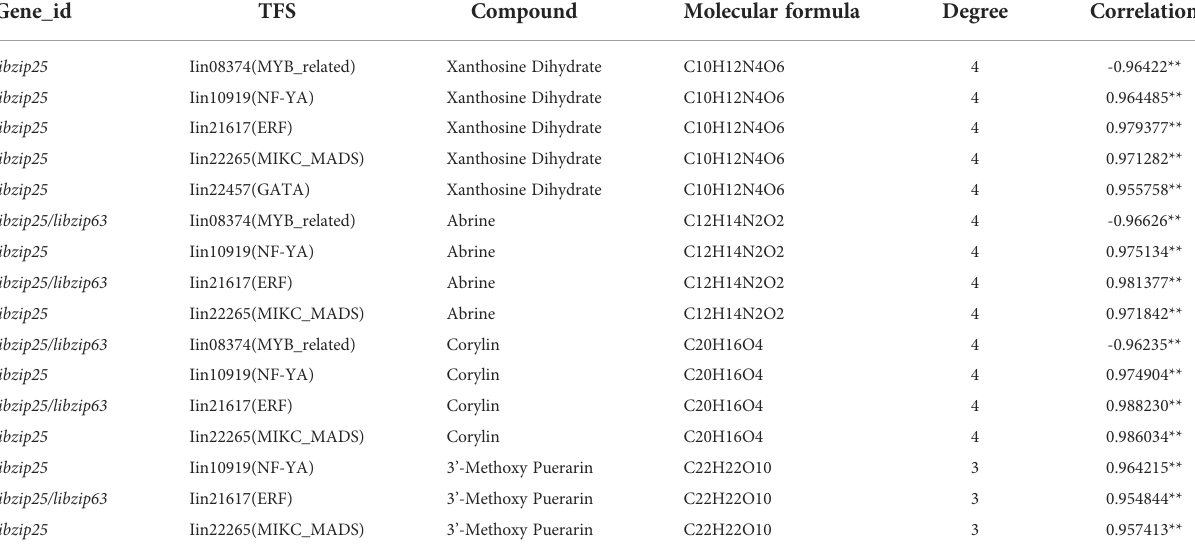
TABLE 2 Correlation analysis of the four compounds most strongly associated with the IibZIP gene regulatory network in leaves of I. indigotica under salt stress. Gene_id TFS Compound Molecular formula Degree